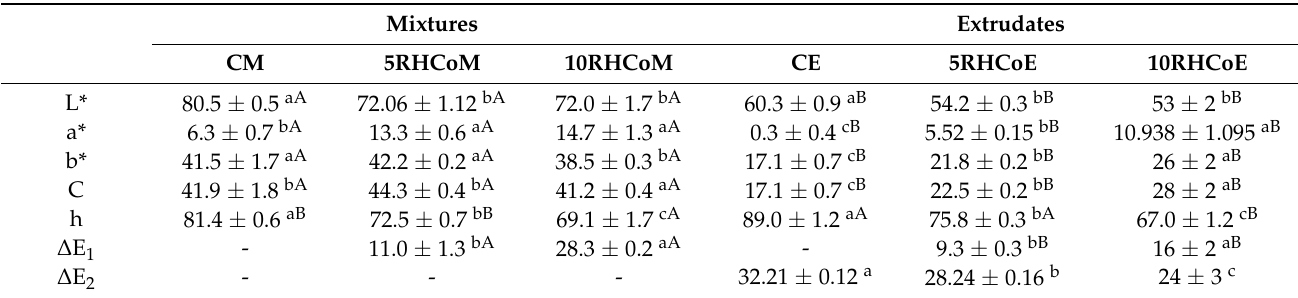
For each parameter, different small letter in superscript within row indicates significant differences between samples ( p < 0.05) comparing samples in mixtures or extrudates. For each sample and parameter, different capital letter in superscript within row indicates significant differences between samples ( p < 0.05) comparing mixtures and extrudates. Samples were mixtures (M) and extrudates (E); C: Control, 5RHCo: 5% of rosehip co-product and 10RHCo: 10% of rosehip co-product. L* (lightness), a* (red/green coordinate), b* (yellow/blue coordinate), C* (chroma), and h* (tone).